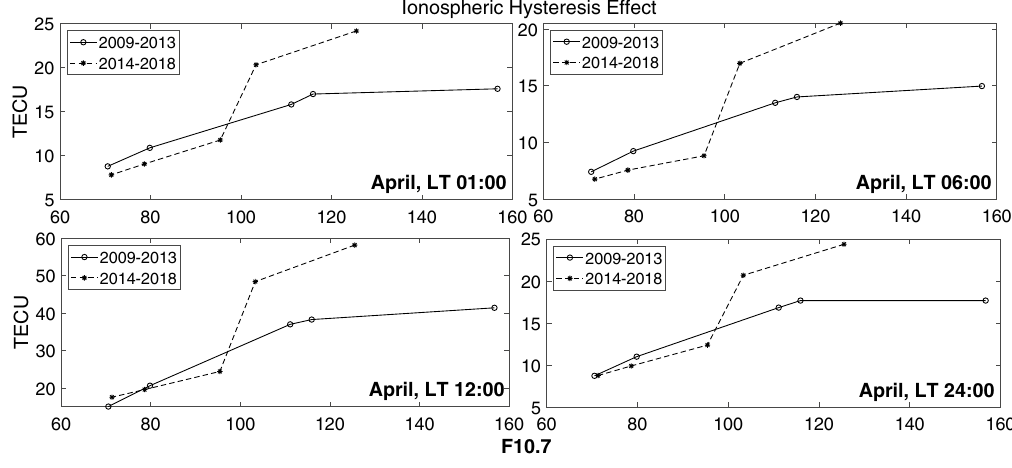
Figure 7. Ionospheric Hysteresis Effect for the time period of